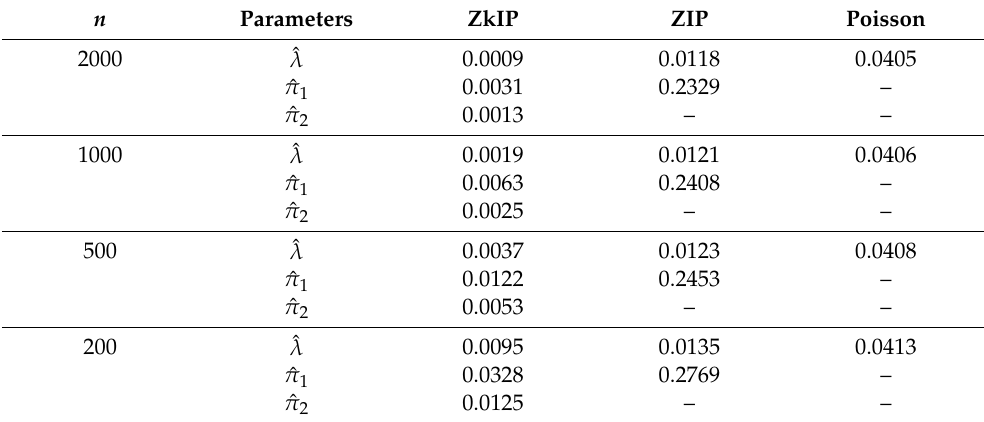
Table 5. Comparison of standardized MSE (SMSE) of the simulated data. True values λ = 2, π 1 = 0.2, π 2 = 0.4, and k = 2.